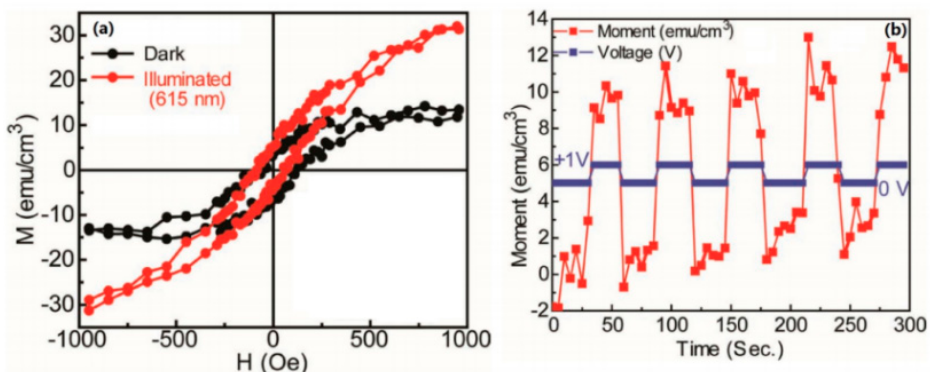
Figure 21. ( a ) In the nw-P3HT/C 60 device, the hysteresis loop of the device before and after illumination and ( b ) the magnetization of the nw-P3HT/C 60 device with the bias voltage, indicating that the device has magnetoelectric coupling nature. By Ren et al. [14] with the permission of Advanced Materials.